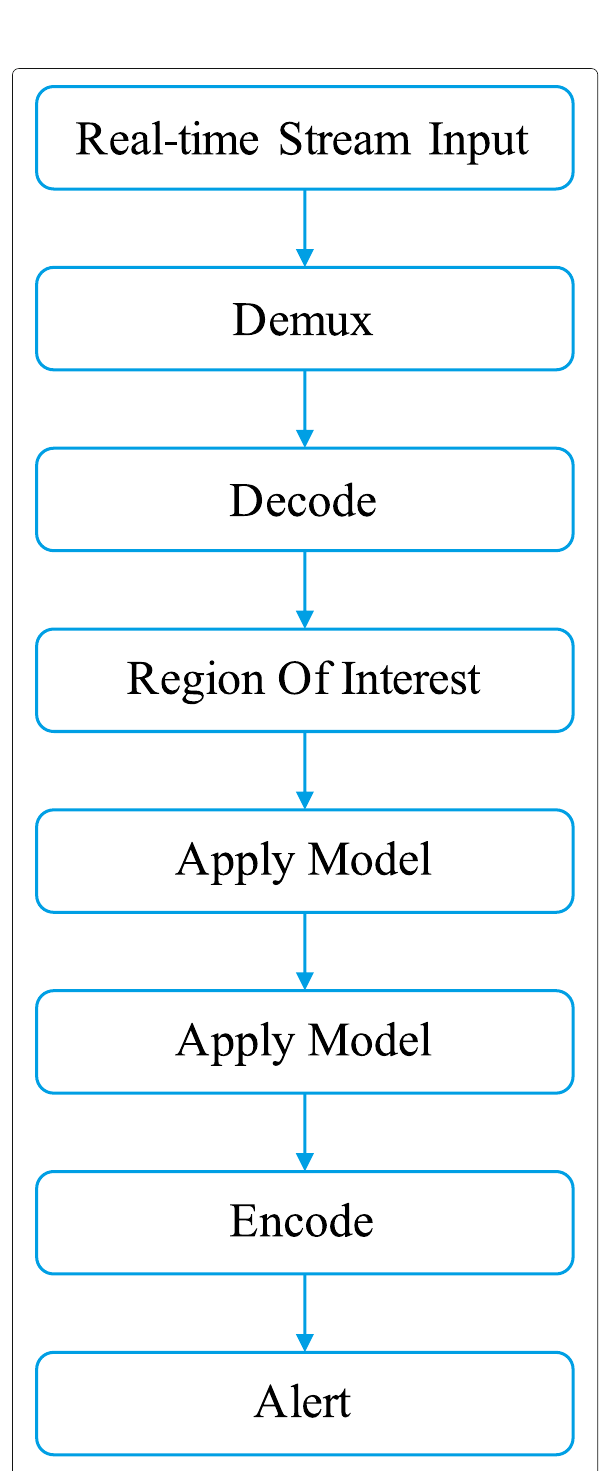
Fig. 7 The pipeline used in this AIoT application